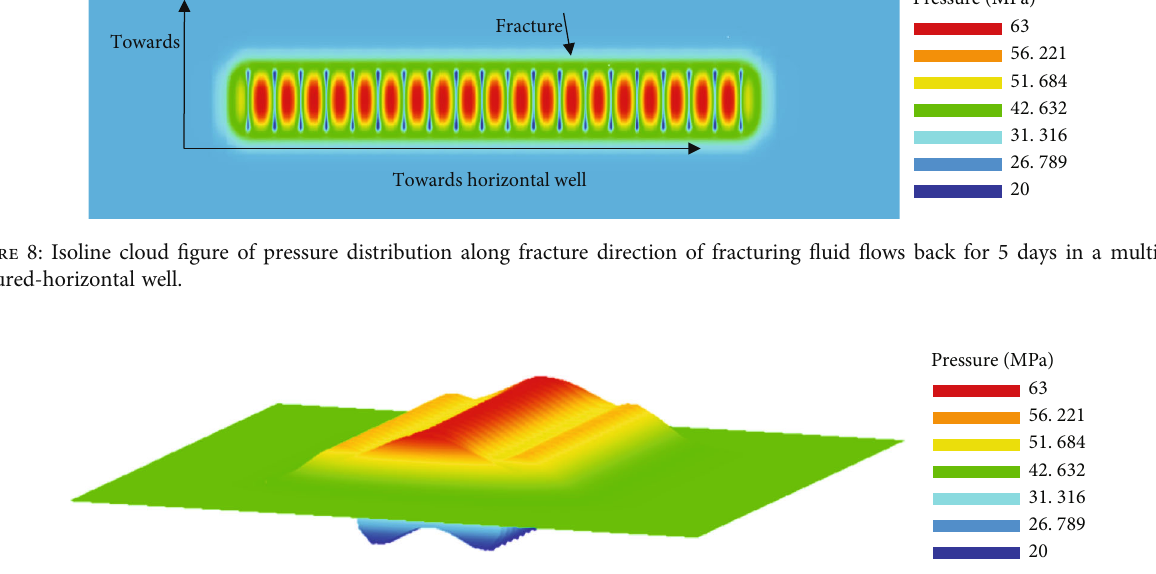
Figure 9: Formation pressure distribution of 5 days fracturing fl uid fl owback in multistage fracturing horizontal